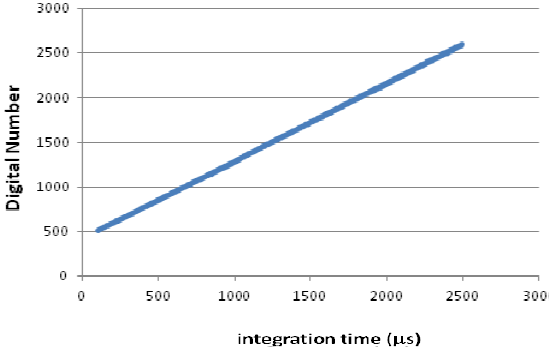
Figure 2. Image digital value (output) versus the integration time at a constant scene illumination (input) for the XEVA 4246